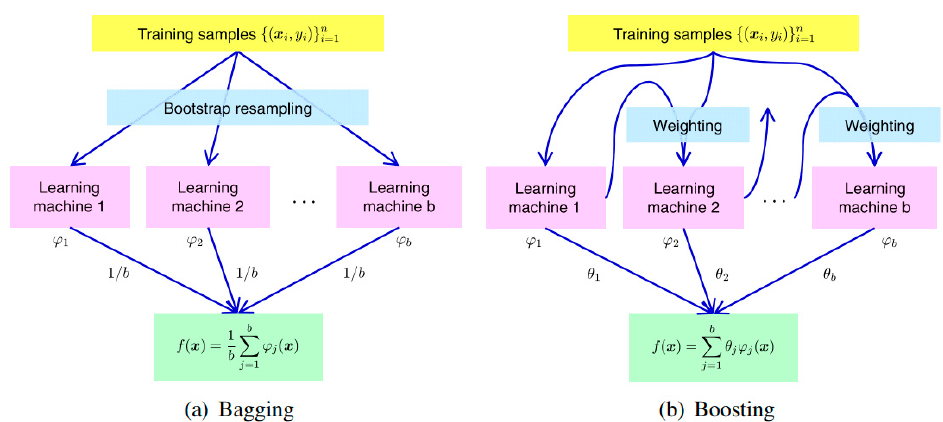
Figure 14. Ensemble learning. Bagging ( a ) trains weak learners in parallel while boosting ( b ) trains them sequentially [53].